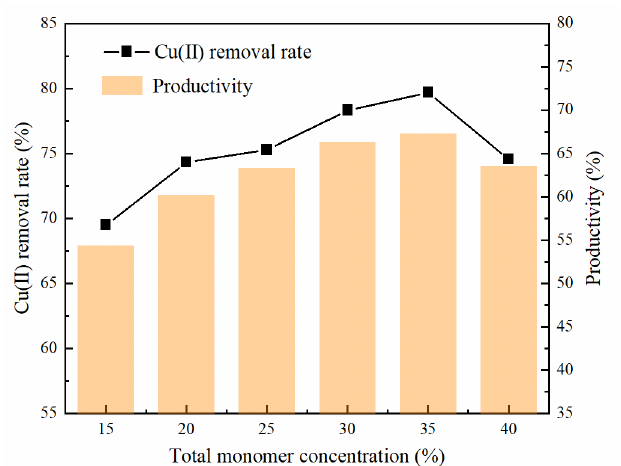
Figure 4. Effect of total monomer concentration on the productivity of MF@AA and Cu(II) removal efficiency.